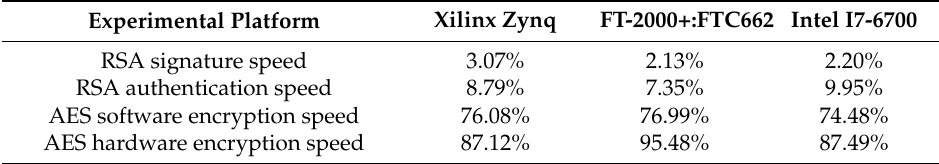
Table 2. The ratio of the lowest security strength to the highest security strength encryption overhead in the